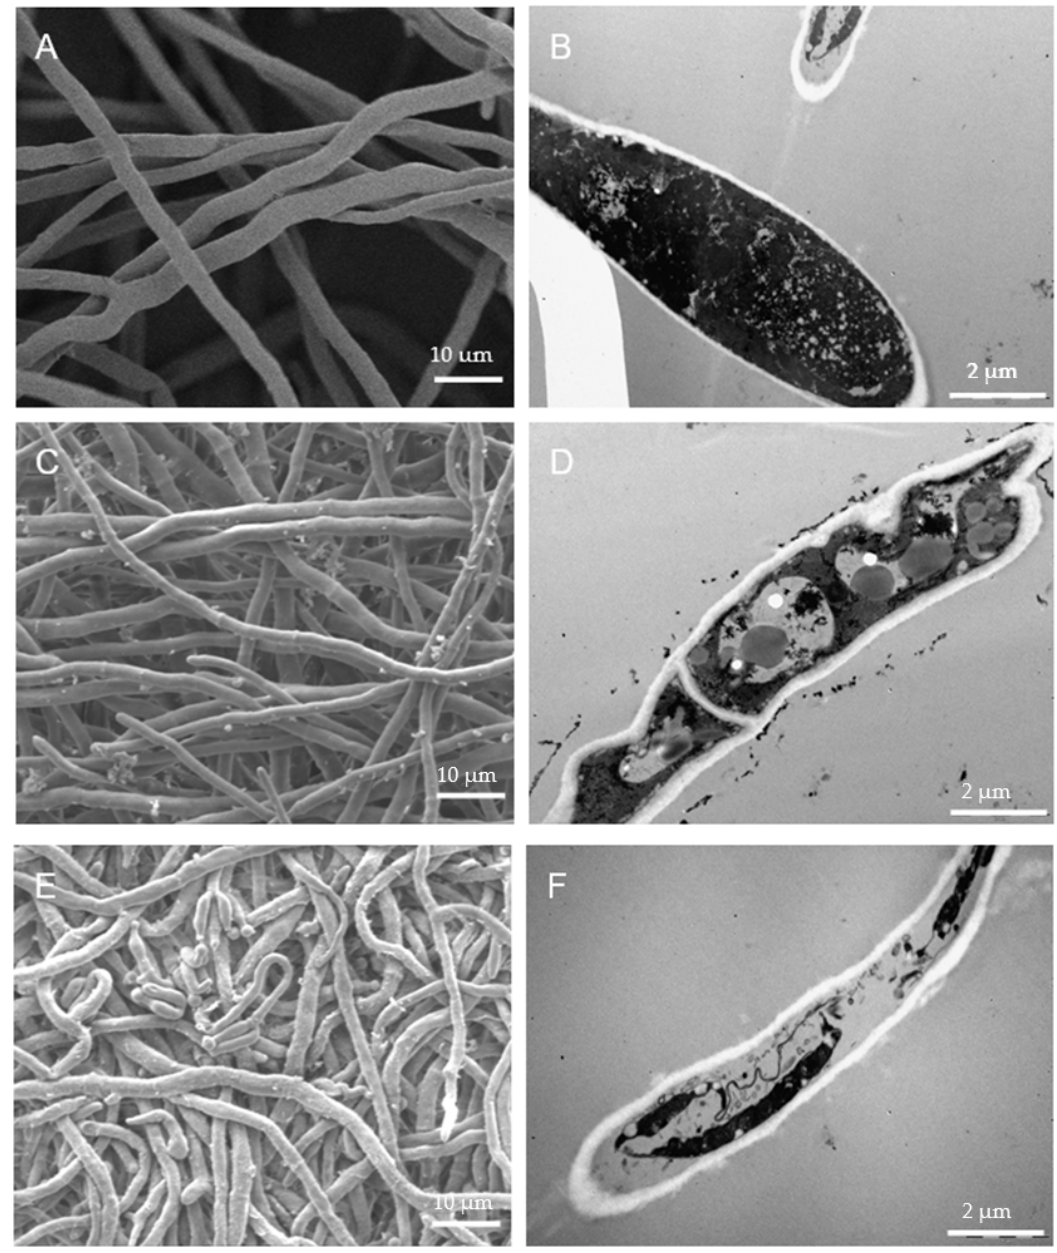
Figure 4. Scanning electron microscopy (SEM) and transmission electron microscopy (TEM) images of P7G against P. italicum . ( A , B ) Control mycelia and cells; ( C , D ) mycelia and cells treated with P7G at EC 50 ; ( E , F ) mycelia and cells treated with P7G at MIC.